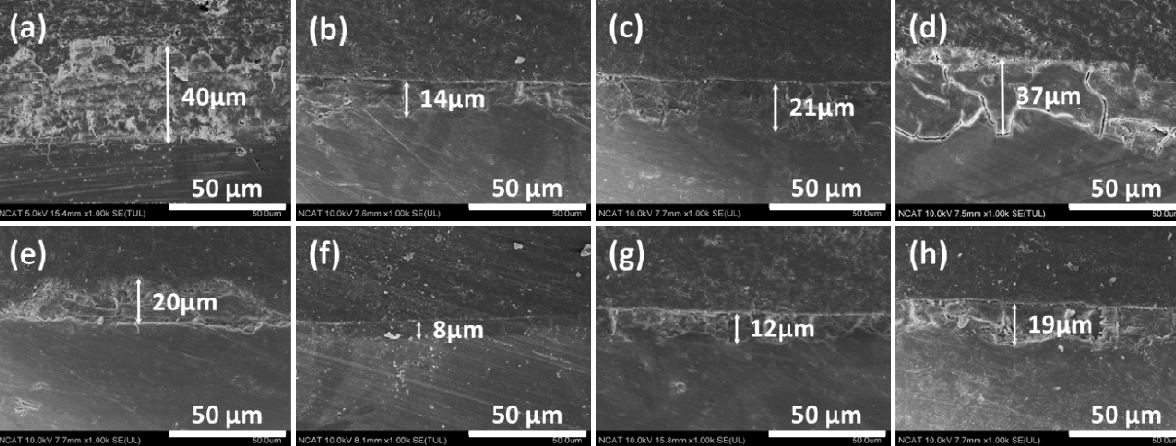
Figure 4. XRD (X-ray diffraction) patterns of AZ31 magnesium alloys after immersion for 10 days in modified Gamble’s solutions with different concentrations of NaHCO